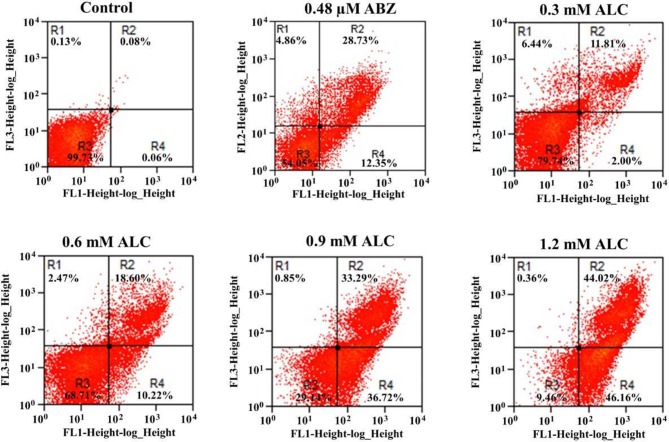
Allicin promotes apoptosis-like death in G. duodenalis trophozoites. Parasites (1 × 106) were exposed to 1.0% double distilled water pH 6.5 (Control) or the indicated concentrations of ALC for 24 h at 37°C then stained with annexin V-PI and processed by flow cytometry. Data shown in the figure are as follows: quadrant R1 are cells positive for necrosis (PI+); quadrant R2 are cells positive for late apoptosis (annexin V+/PI+); quadrant R3 are cells negative for both markers and quadrant R4 are cells positive for early apoptosis (annexin V+). As a positive control, trophozoites were exposed to the indicated cytotoxic concentration of albendazole (ABZ). Percentages of total cells are indicated within each quadrant. The dot plots are representative of two independent experiments.